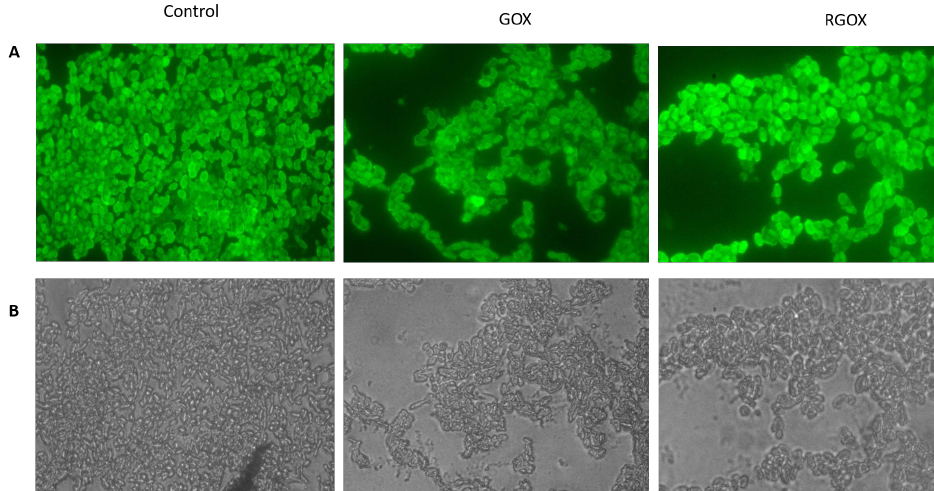
Figure 6. Inhibition of S. aureus biofilm by synthesized compounds: ( A ) shows fluorescence microscopic images while ( B ) shows bright-field microscopic images, the three panel shows untreated control image of S. aureus biofilm, biofilm treated with GOX, biofilm exposed to RGOX as revealed by fluorescence Nanomaterials 2020 , 10 , x FOR PEER REVIEW microscopy (100 × magnification).